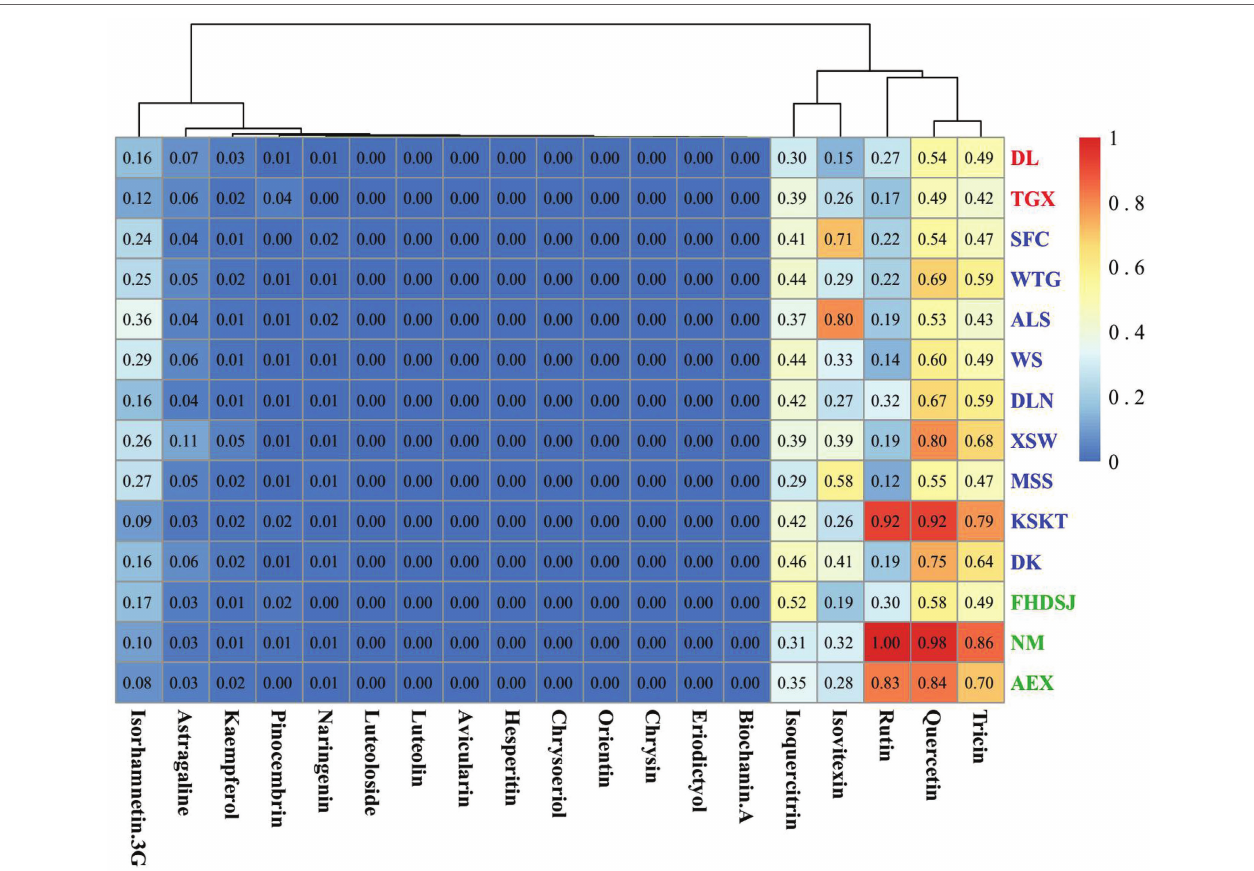
FIGURE 4 | Cluster heatmap of flavonoid metabolites in A. squarrosum . Metabolites and populations two-way clustering heatmap. Color depth represents average intensity of metabolite contents in 14 populations of A. squarrosum . Red represents highest content and blue represents lowest content. Altitude categories are encoded using three colors: green, blue, and red indicates sample sites of low-altitude (~0–1,000 m), middle-altitude (~1,000–2,000 m), and high-altitude (~2,000– 4,000 m),